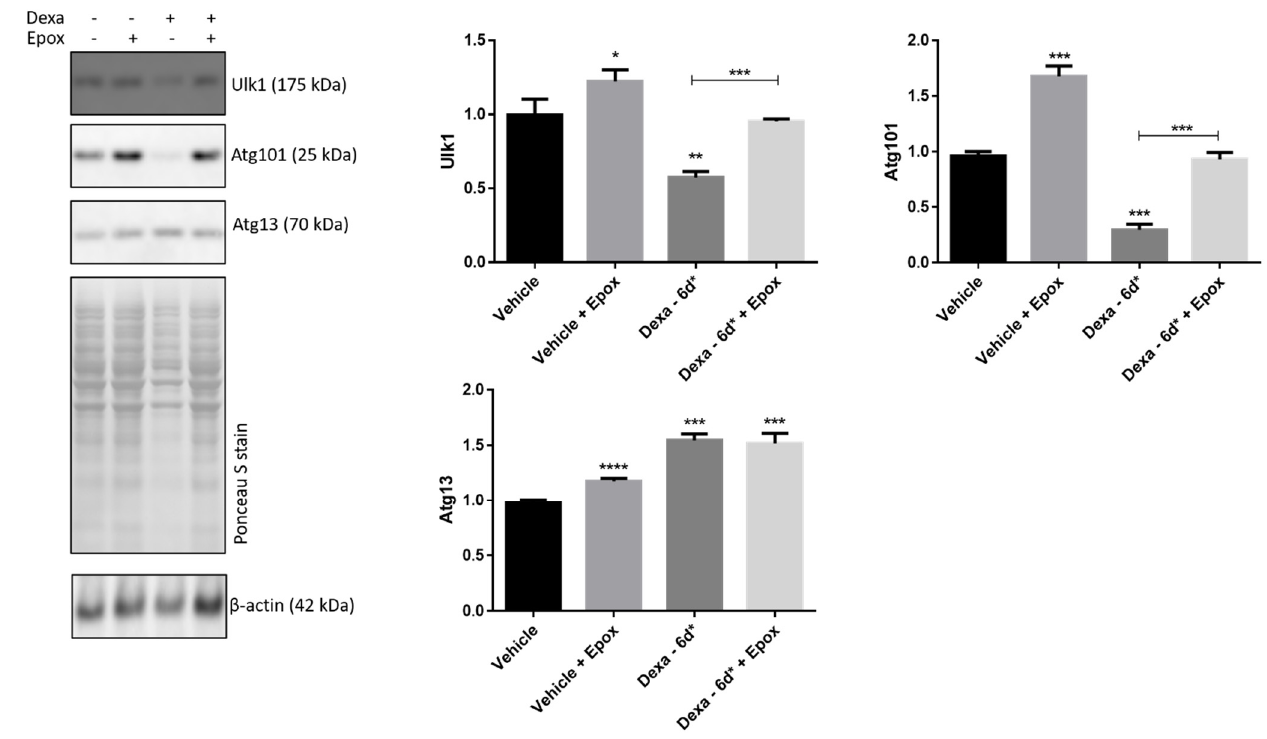
Figure 7. Enhanced turnover of Ulk-1 and Atg101 in Dexa-treated TMCs. (A) Immunoblotting of Ulk-1, Atg101 and Atg13 in whole cell lysates of TMCs. Normalization was performed on total proteins (Ponceau S stain). * p < 0.02; ** p < 0.0004; *** p < 0.0001; **** p < 0.001. A representative experiment of three independent observations is reported ( n = 3); one-way ANOVA followed by Tukey’s post hoc significance test.